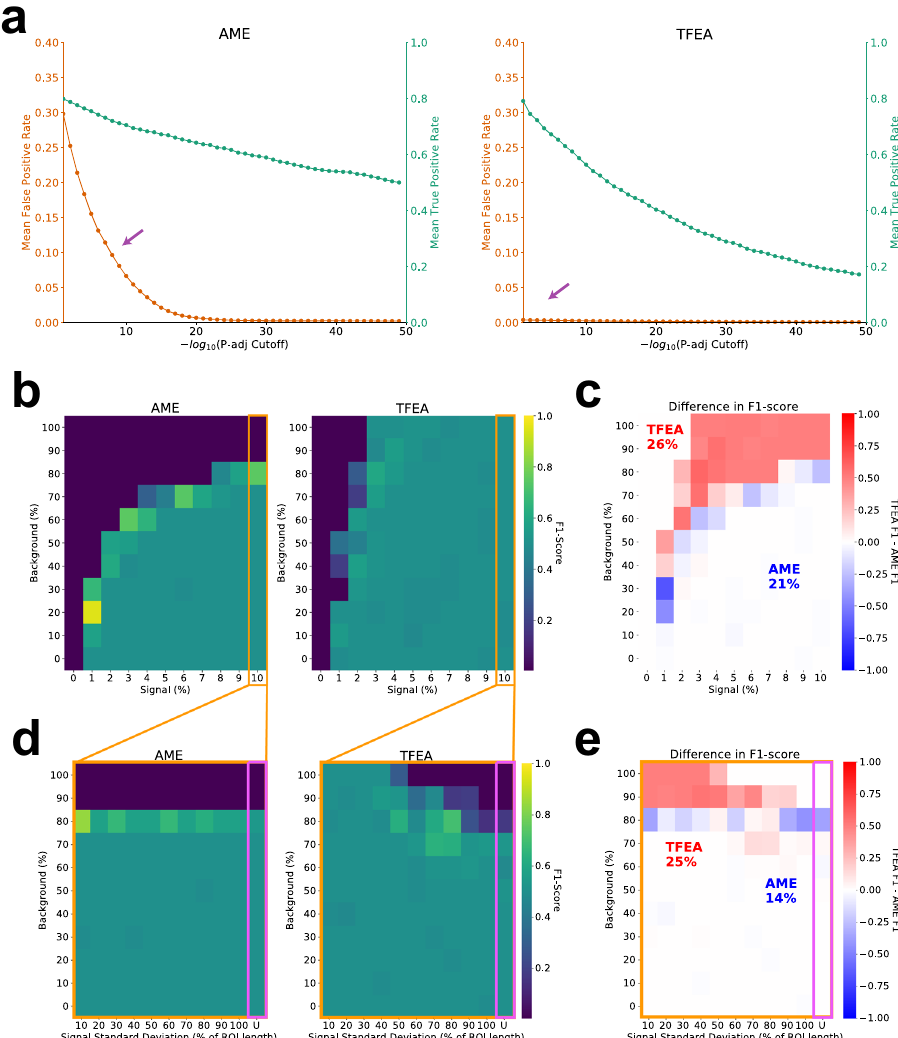
Fig. 4 TFEA balances TF positional and differential signal. a Optimal cutoffs are determined using the mean true positive rate (TPR; green) and mean false positive rate (FPR; orange) across the different signal and background levels as a function of varying the threshold cutoff. b F1 score of AME and TFEA for varied signal and background, using optimal AME cutoff 1e − 30 and TFEA cutoff 0.1. c Difference in F1 score between TFEA and AME across all simulations ( n = 121; value = F 1 TFEA − F 1 AME ). TFEA (red) outperforms AME (blue) in 26% of cases (value> 0) whereas AME outperforms TFEA in 21% of cases (value < 0). d F1 scores and e difference in scores for highest signal tested (10% signal), now varying the standard deviation of the signal and background. See Supplementary Fig. 17 for more details on